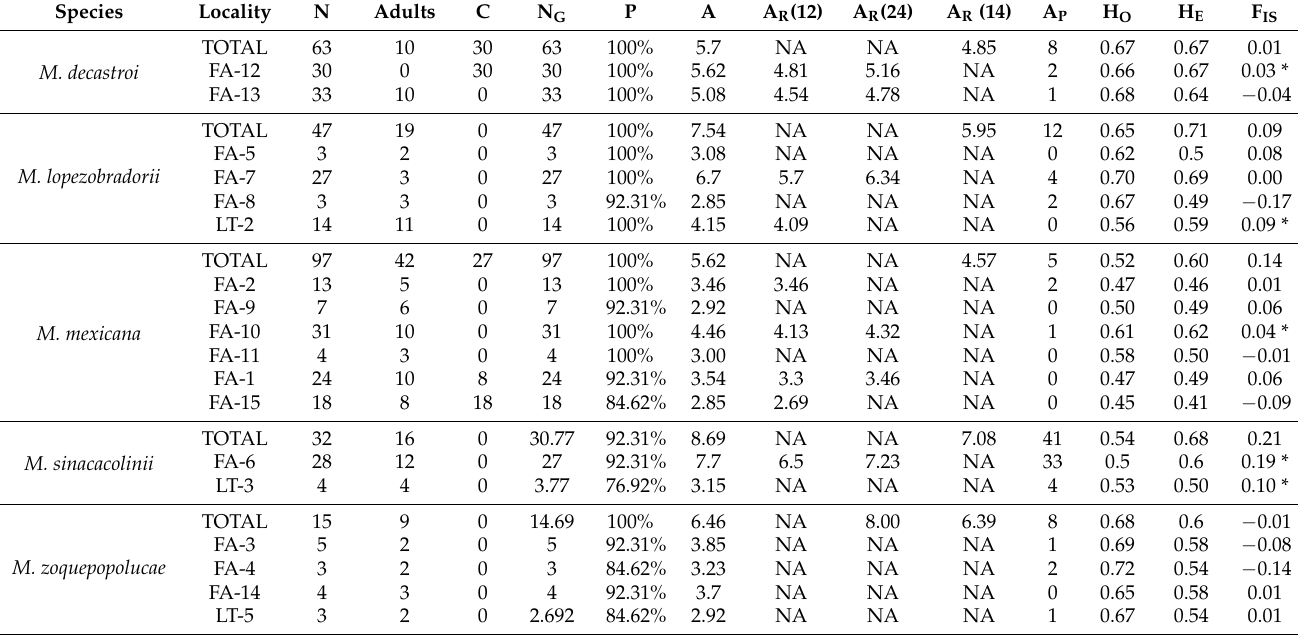
Table 4. Genetic diversity measures estimated per sampling locality of different Magnolia species in Puebla and Veracruz, Mexico. N: sample size; C: number of cultivated individuals; N G : (mean) number of genotyped individuals. A: (mean) number of alleles. A R : allelic richness whereby the number of individuals to which the rarefaction is undertaken is between brackets. A P : (mean) number of private alleles. H O : (mean) observed heterozygosity. H E : (mean) expected heterozygosity. F IS : inbreeding coefficient. Significant deviations from Hardy–Weinberg Proportions (HWP): * ( p = 0.05) are only calculated at the level of